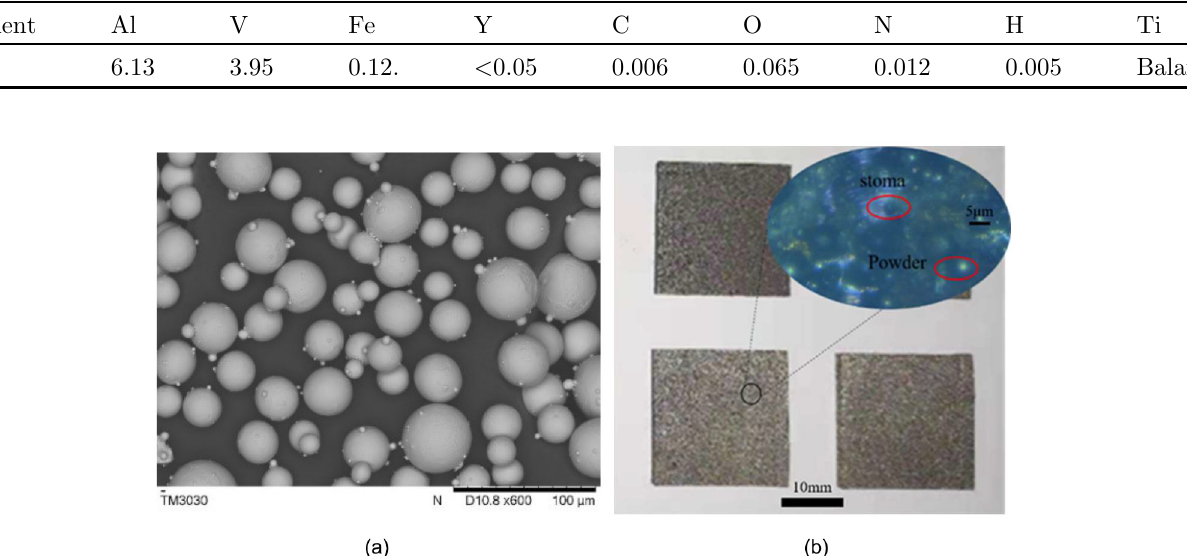
Fig. 3. Ti6Al4V powder and formed parts. (a) Ti6Al4V powder. (b) Formed parts.